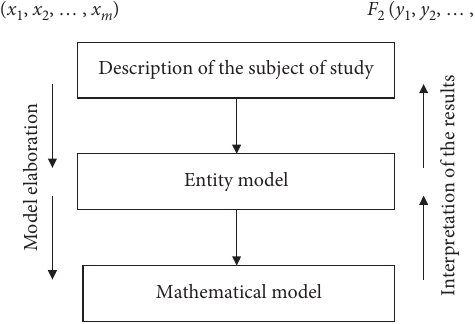
Figure 2: Model of